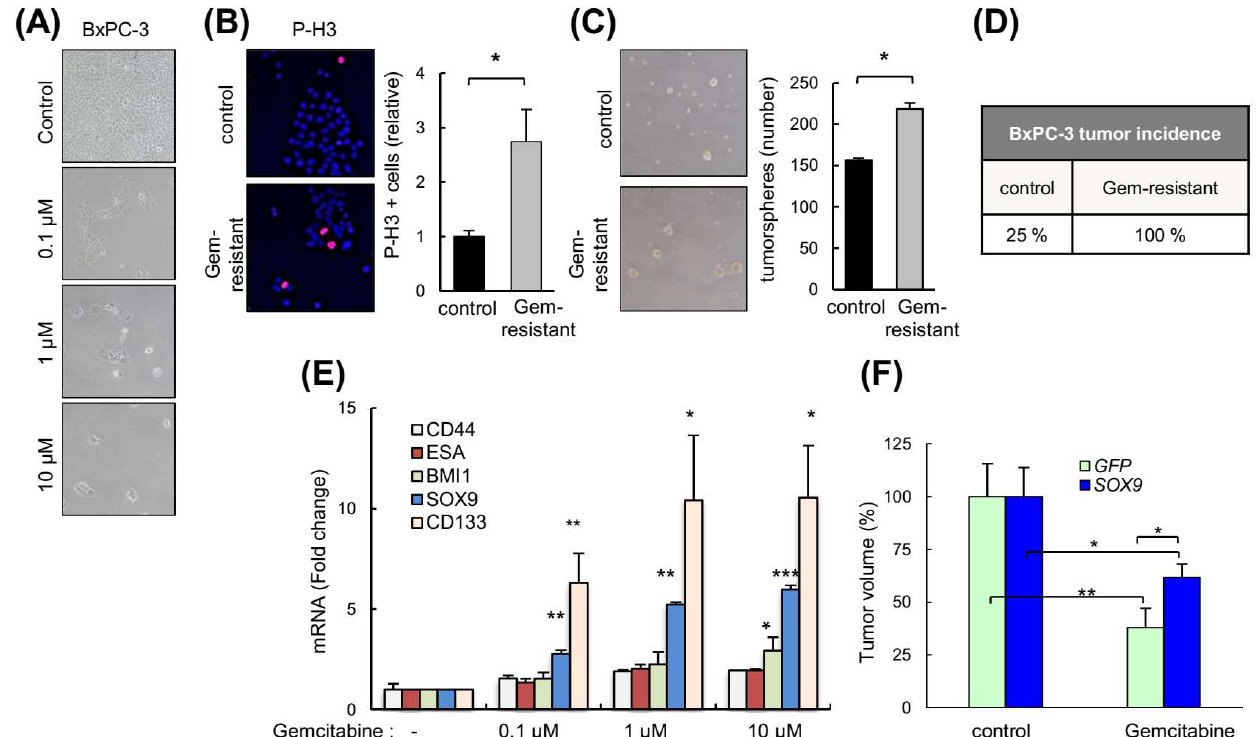
Figure 7. High levels of SOX9 confer chemoresistance. ( A ) Representative images of BxPC-3 cells untreated (parental) and gemcitabine-resistant cells after 120 h of treatment with different concen- trations of gemcitabine (0.1, 1 and 10 µM). ( B ) Representative image and representation of the proportion of BxPC-3 and BxPC-3 gemcitabine-resistant cells (Gem-resistant) positive for the mitosis marker phospho-histone H3 ( p -H3). ( C ) Representative image and quantification of the number of tumorspheres derived from BxPC-3 and BxPC-3 gemcitabine-resistant cells. ( D ) Percentage of sub- cutaneous tumors formed from BxPC-3 parental and gemcitabine-resistant cells (1x10 6 cells/injec- tion). ( E ) SOX9 , CD133 , BMI1 , CD44 and ESA mRNA expression in BxPC-3 control and gemcitabine- resistant cells ( n = 4). ( F ) Volume of tumors from IMIM-PC2 GFP and SOX9 cells in nude mice treated intraperitoneally once per week with vehicle or gemcitabine 5 mg/Kg ( n = 5). Asterisks (*, **, and ***) indicate statistical significance ( p < 0.05, p < 0.01, and p < 0.001, respectively).